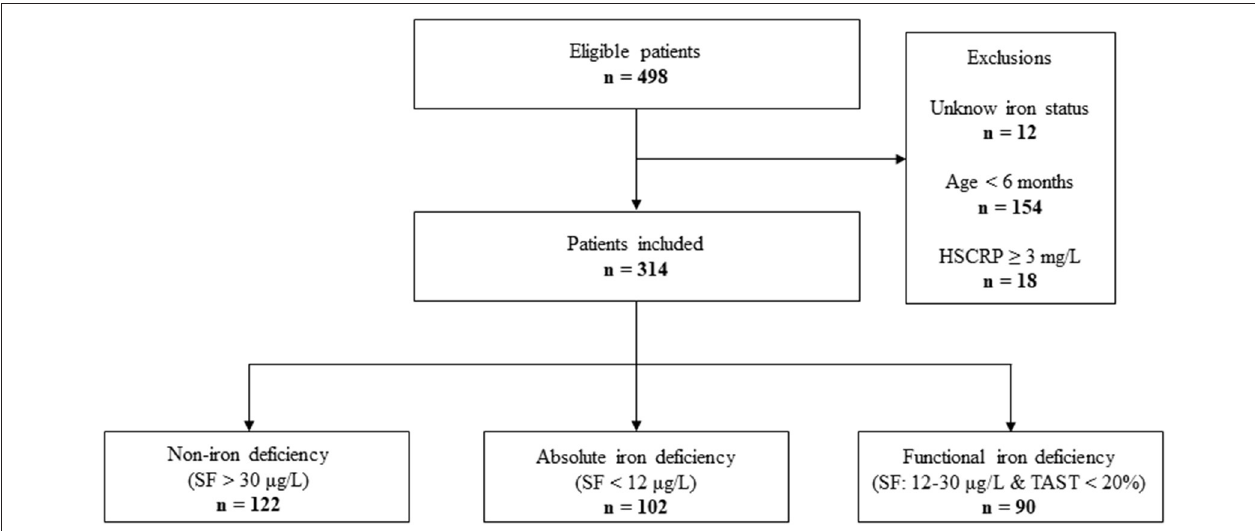
FIGURE 1 | STROBE-style study flow chart outlining recruitment to and exclusion from the analysis sample. HSCRP, hypersensitive C reactive protein; SF, serum ferritin; TAST, transferrin saturation. with inter-quartile range. Differences among groups were using histograms and Q–Q plots. The normally distributed compared using the Analysis of Variance or the Kruskal–Wallis data were presented as mean with standard deviation, and test, depending on the normal distribution. Categorical variables non-normally distributed variables were presented as median